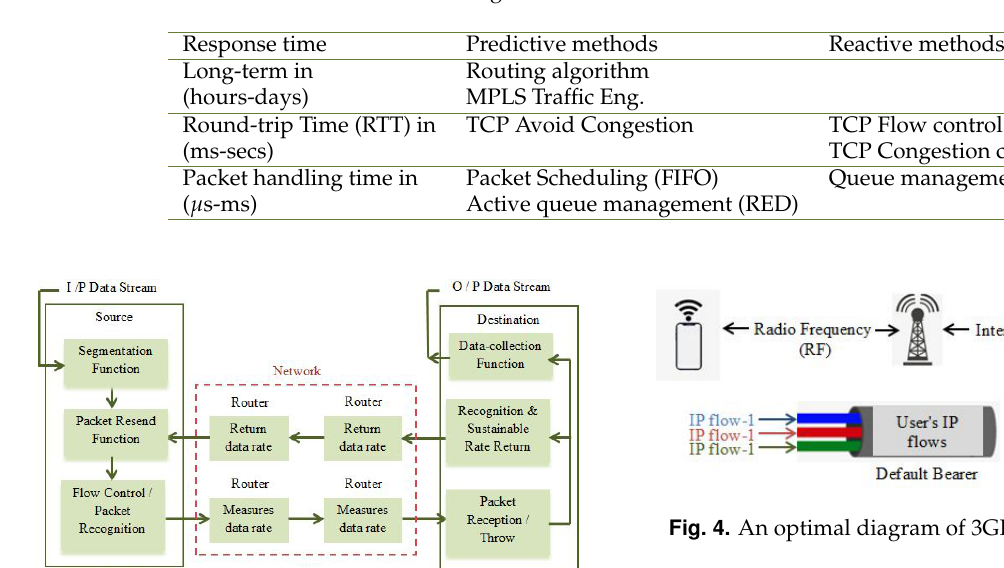
Table 1. Traffic and congestion control mechanisms in different time scales